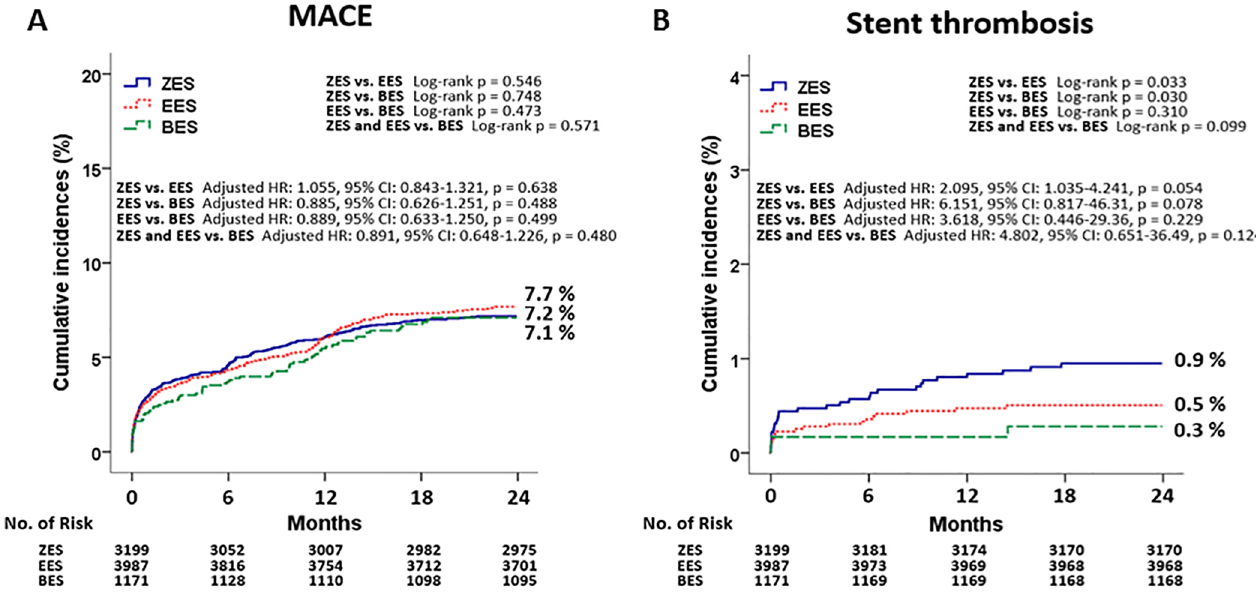
Fig 2. Kaplan-Meier Curved Analysis for MACE (A) and stent thrombosis (B) at 2-year before adjustment. MACE, major adverse cardiac event; ZES, zotarolimus-eluting stent; EES, everolimus-eluting stent; BES, biolimus-eluting stent; HR, hazard ratio; CI, confidence interval.